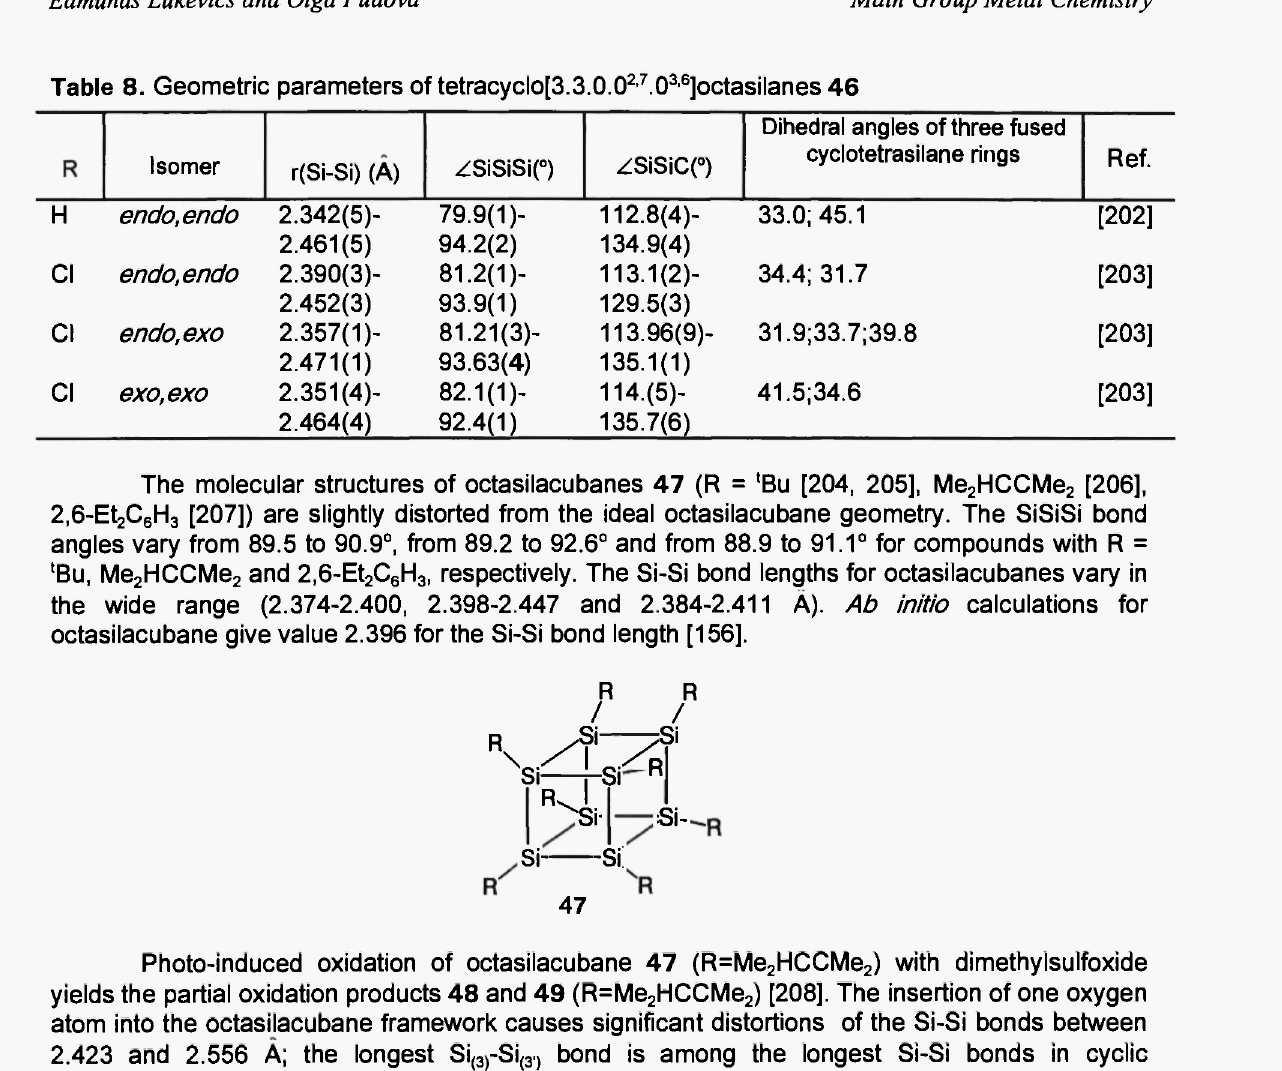
Table 8. Geometric parameters of tetracyclo[3.3.0.0 2 ' 7 .0 3 ' 6 ]octasilanes 46 Isomer